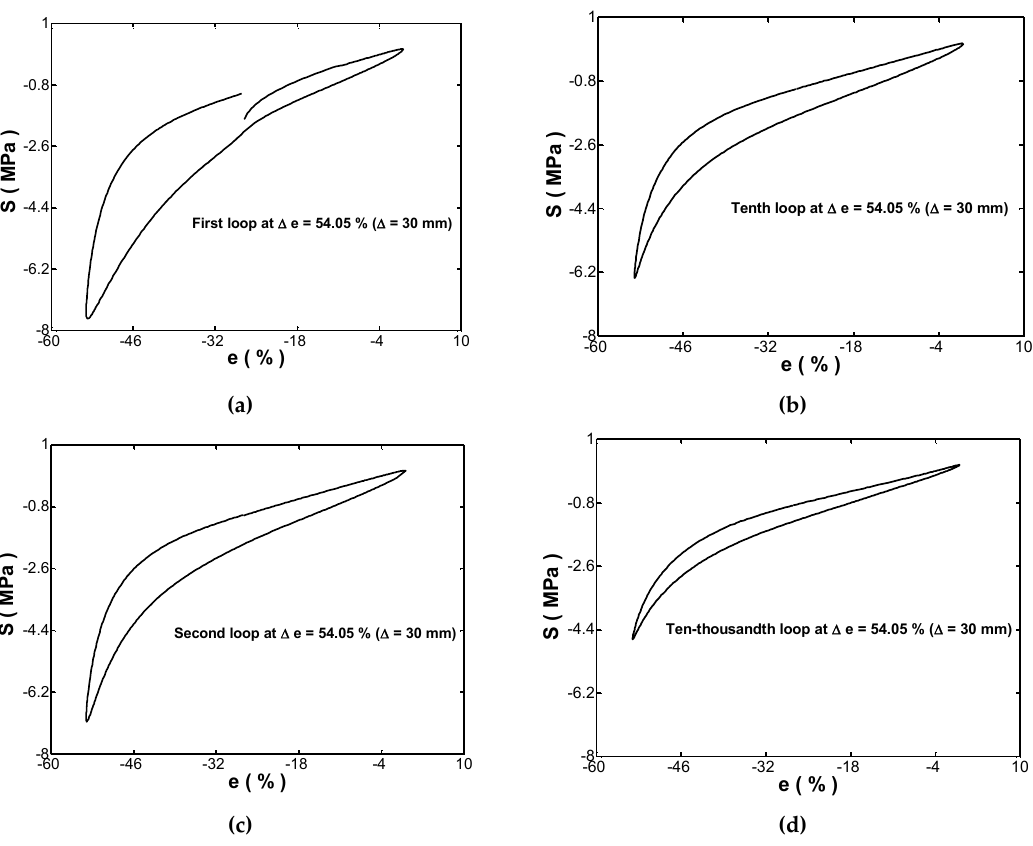
Figure 3. Cyclic hysteresis loops for: ( a ) first, ( b ) second, ( c ) tenth, and ( d ) ten-thousandth cycles in cyclic compression testing with A e = − 1 and strain range of 54.05 %.